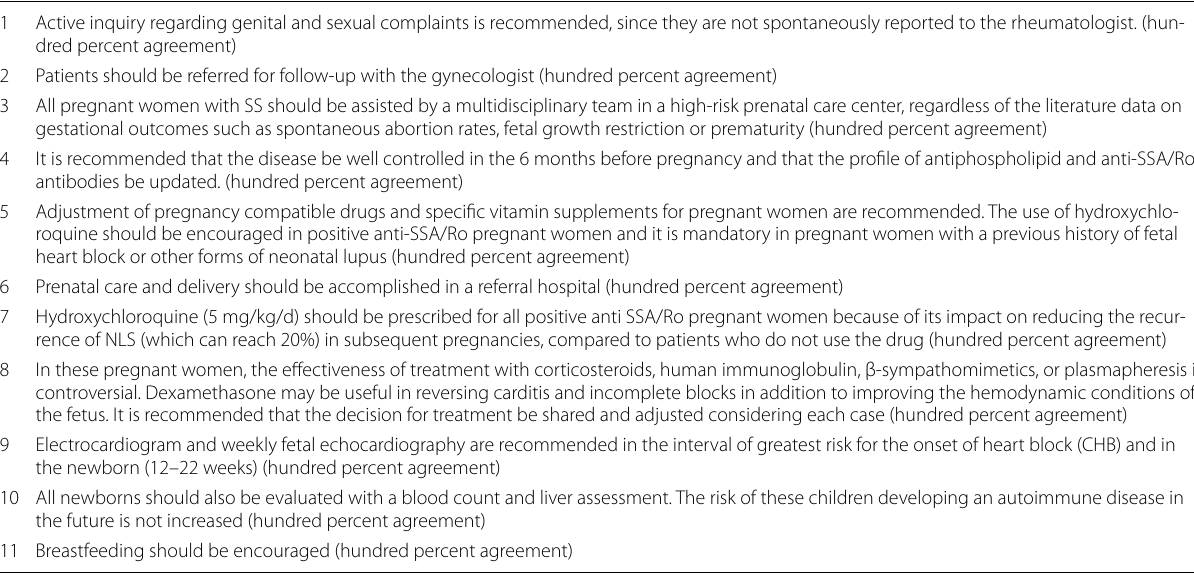
Table 1 Brazilian recommendations for the gynecological and obstetric care of women of Sjogren